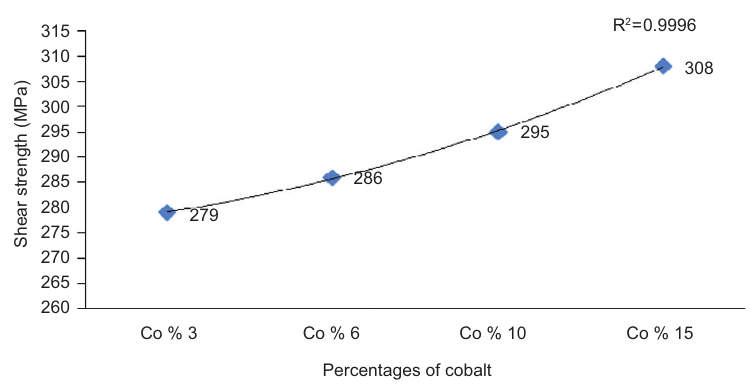
Figure 5 Shear strength curve against the percentage of Co